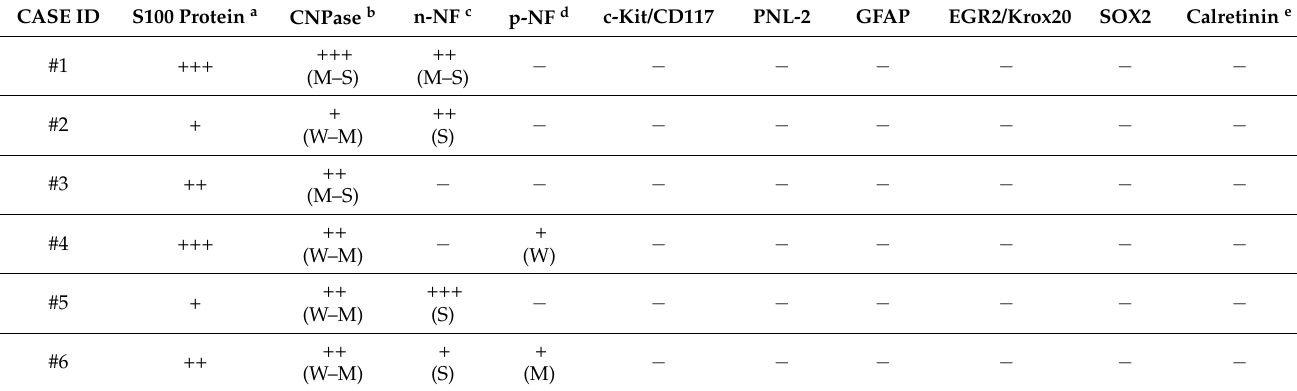
Table 2. Overview of the immunohistochemical findings in skin nodules from six goldfish.